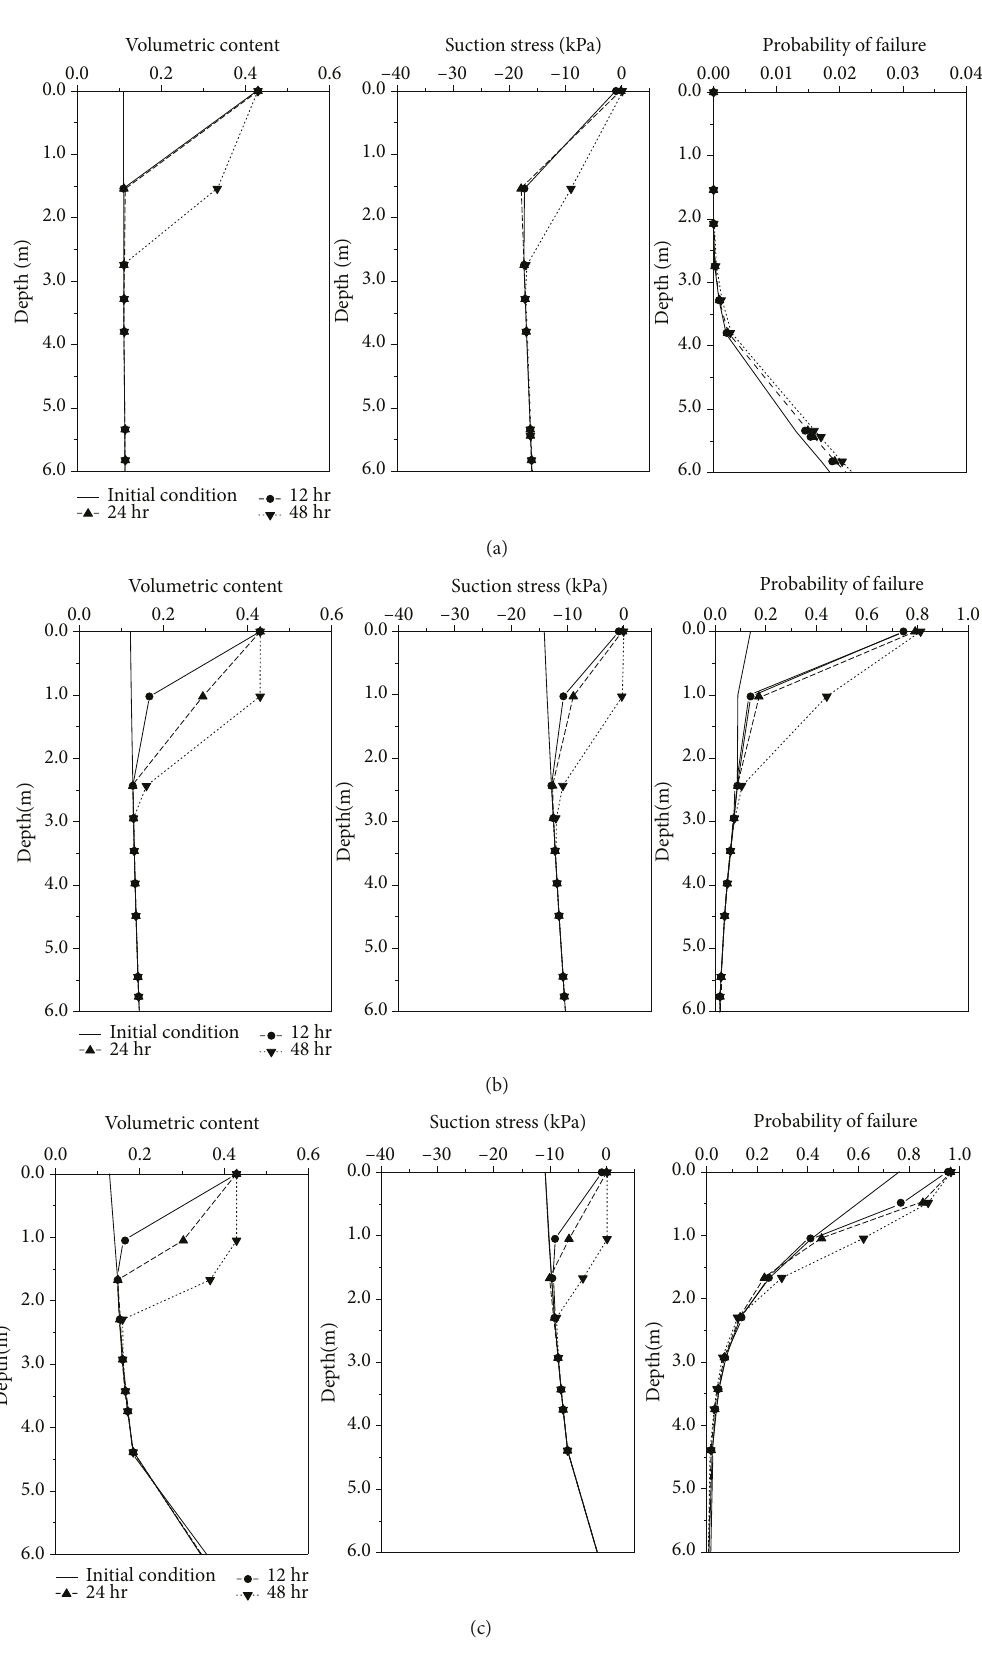
Figure 8: Results of water content, suction stress, and failure probability in the loam slope at 0, 12, 24, and 48 hours under rainfall conditions (a) at the top of the slope, (b) middle of the slope, and (c) toe of the